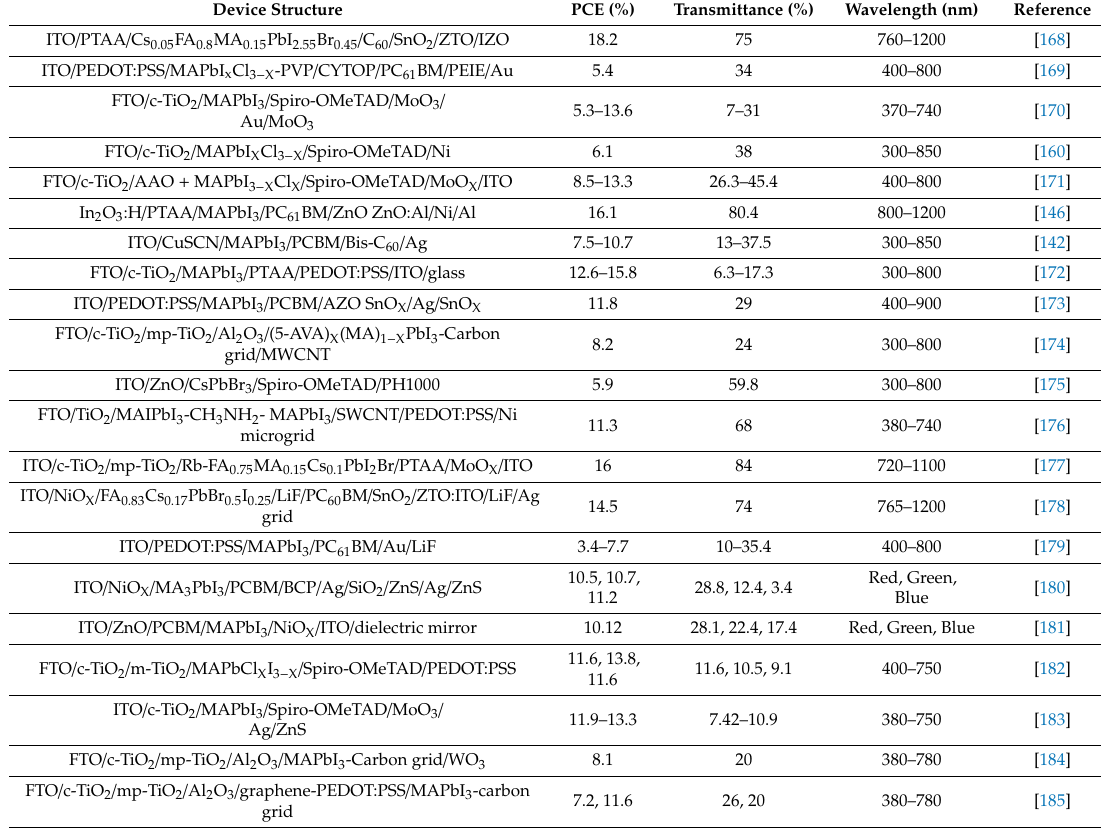
Table 5. The e ffi ciency of various semi-transparent PSCs at their di ff erent transmission wavelength. Device